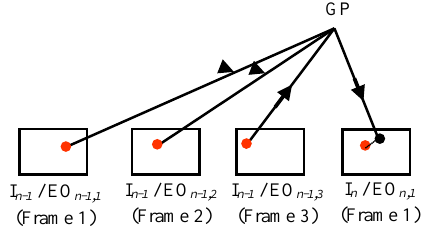
Figure 3. Moving object removal through a